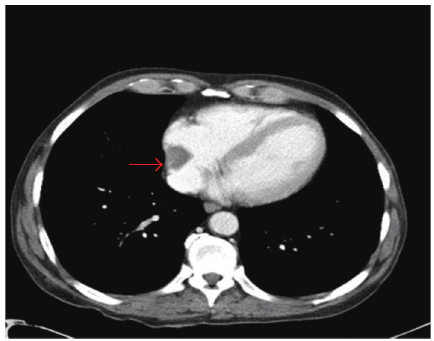
Figure 1: Showing CRAT 2 weeks prior to